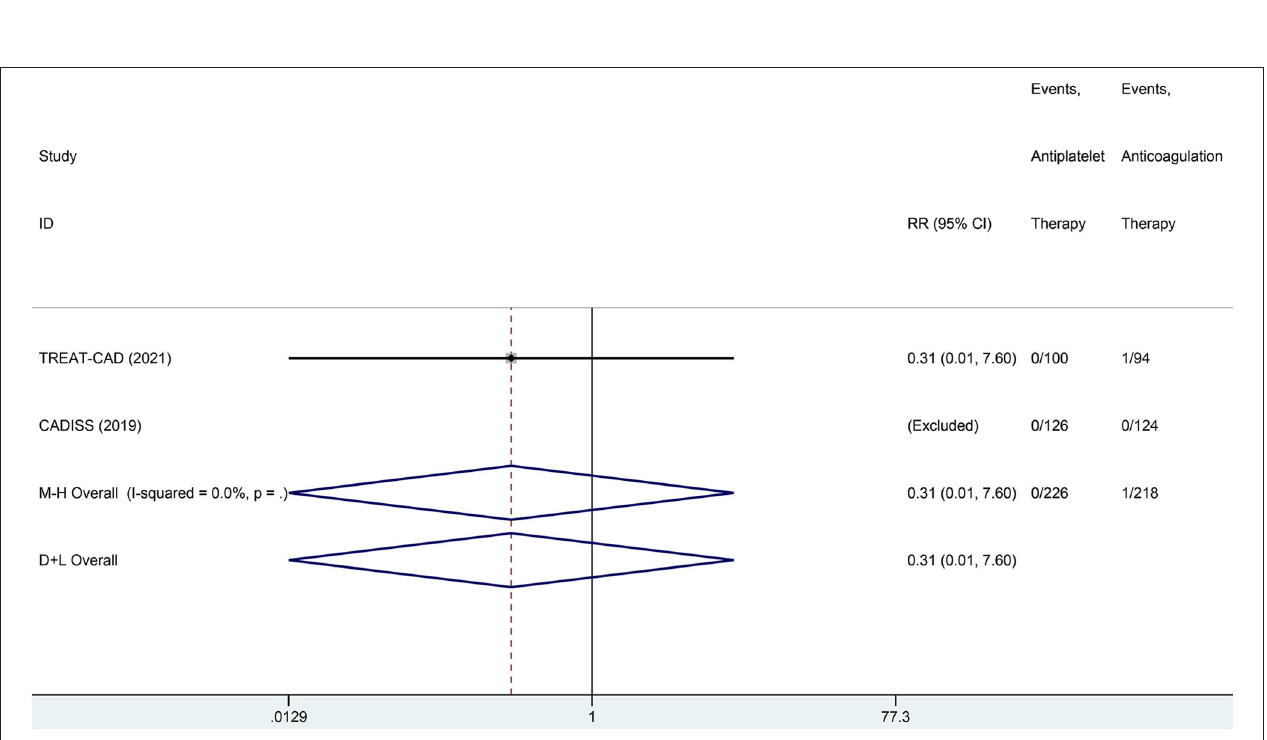
FIGURE 6 | A forest plot of comparison for major extracranial bleeding between the antiplatelet and anticoagulation in the ITT population.